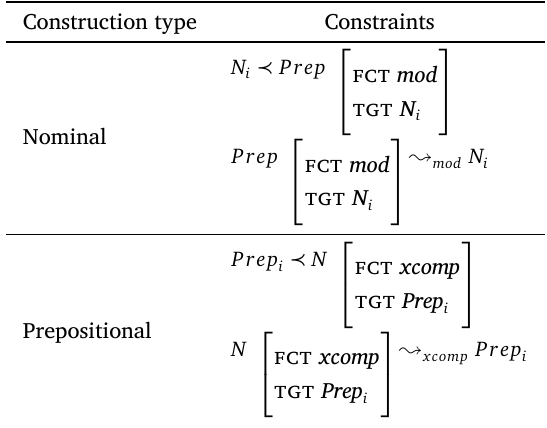
Table 5: Construction